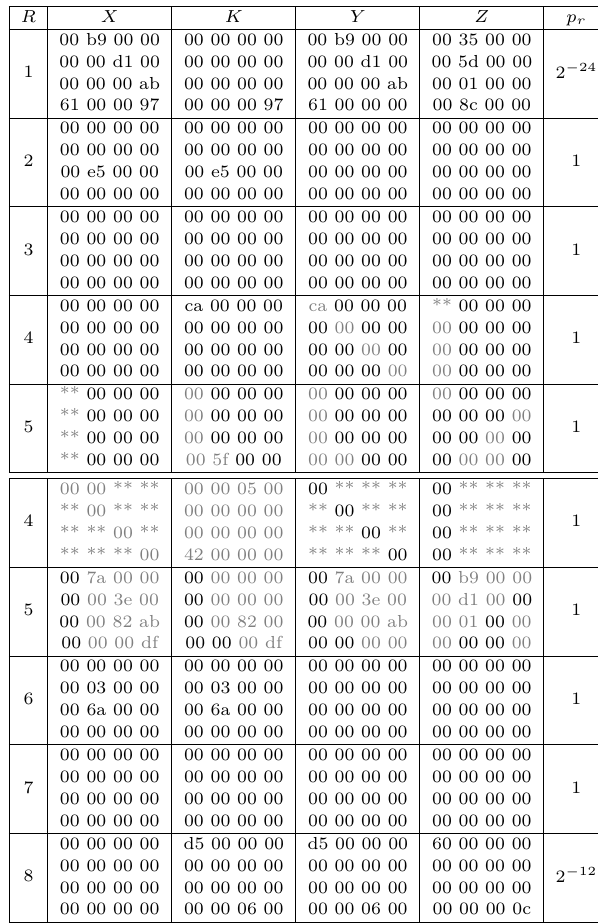
Table 7: 8-round distinguisher of